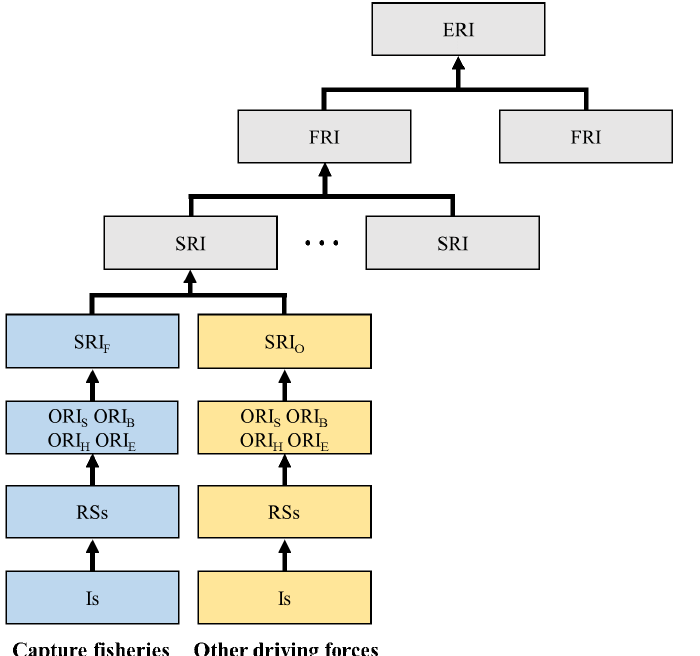
Figure 3. The nested structure of indicators and risk indices used in the extended ecosystem-based fisheries assessment approach. Is denotes indicators; RSs denotes the risk scores for Is ; ORI S , ORI B , ORI H , and ORI E , denote the objective risk indices for sustainability, biodiversity, habitat quality, and socio-economic benefit, respectively; SRI is the species risk index; FRI is the fisheries risk index; and ERI is the ecosystem risk